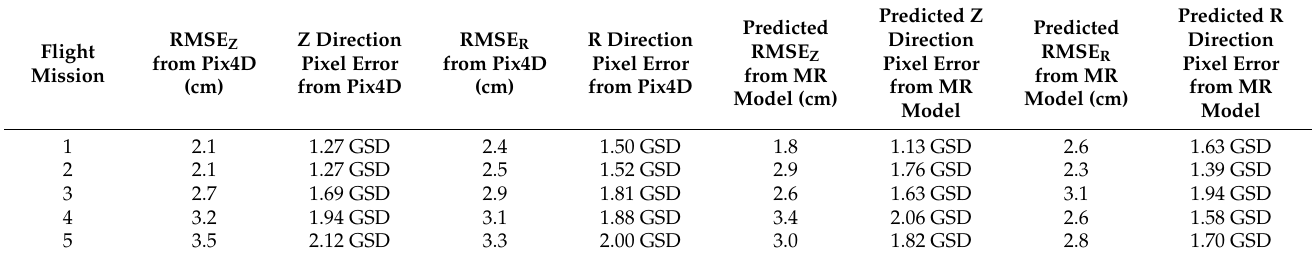
Table 7. Results of Butner UAS Test Site from Pix4DMapper and MR Models.